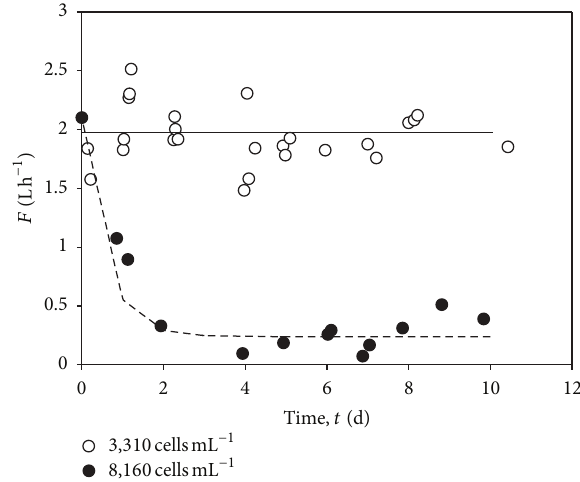
Figure 7: Mytilus edulis . Mean individual filtration rates ( 𝐹 ) measured in two groups of mussels ( 𝑛 = 45 ) exposed during 10d to 3,310 ± 730 ( ⃝ , 𝐿 = 31.9 ± 1.3 mm) and 8, 160 ± 1, 140 cellsmL −1 ( ∙ , 𝐿 = 32.2 ± 0.6 mm), respectively. The curve for filtration rates measured at the high algal concentration resulting in saturation +(𝐹 − Figure 9: Mytilus edulis. Filtration changing rates ( Δ𝐹 ) of mussels reduction was obtained from the following equation: 𝐹 = 𝐹 0 red ) × exp (−𝑡/𝜏) , where 𝐹 = 1.9 ± 0.2 L h −1 , 𝐹 = 0.24 Lh −1 , and 𝐹 as a function of salinity changing rates ( Δ𝑆 ) in all experiments based 0 red red 𝜏 = 0.561 d. on data from Table